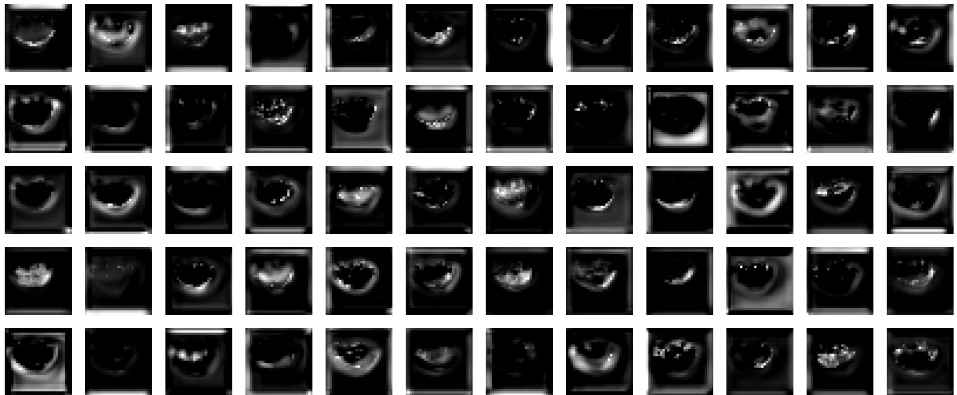
Figure 7. Partial feature maps extracted from backbone